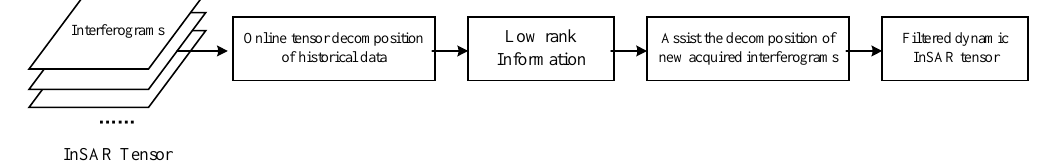
Figure 2. The overall workflow of online dynamic InSAR tensor filtering.